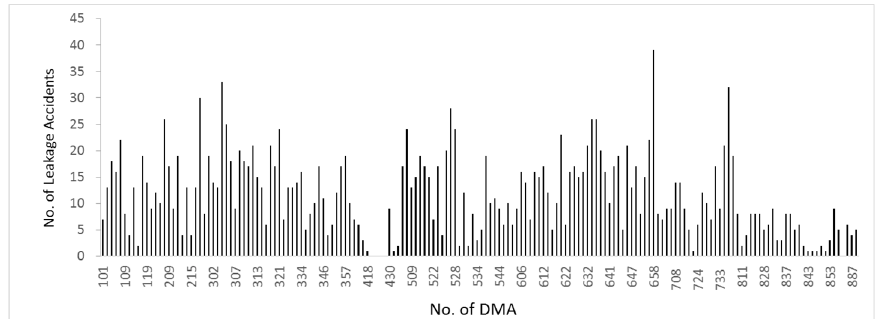
Figure 9. Data on No. of Leaks in Incheon’s DMAs.